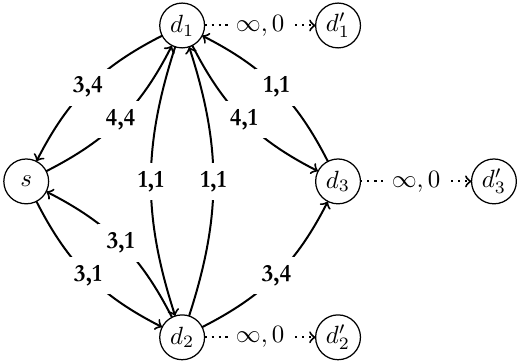
Figure 2: Transformation of the network in Figure